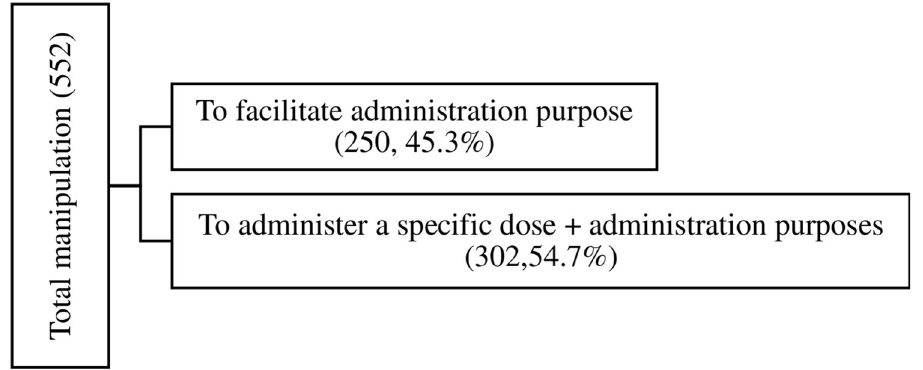
Fig 1. Reasons for administering manipulated ODFs